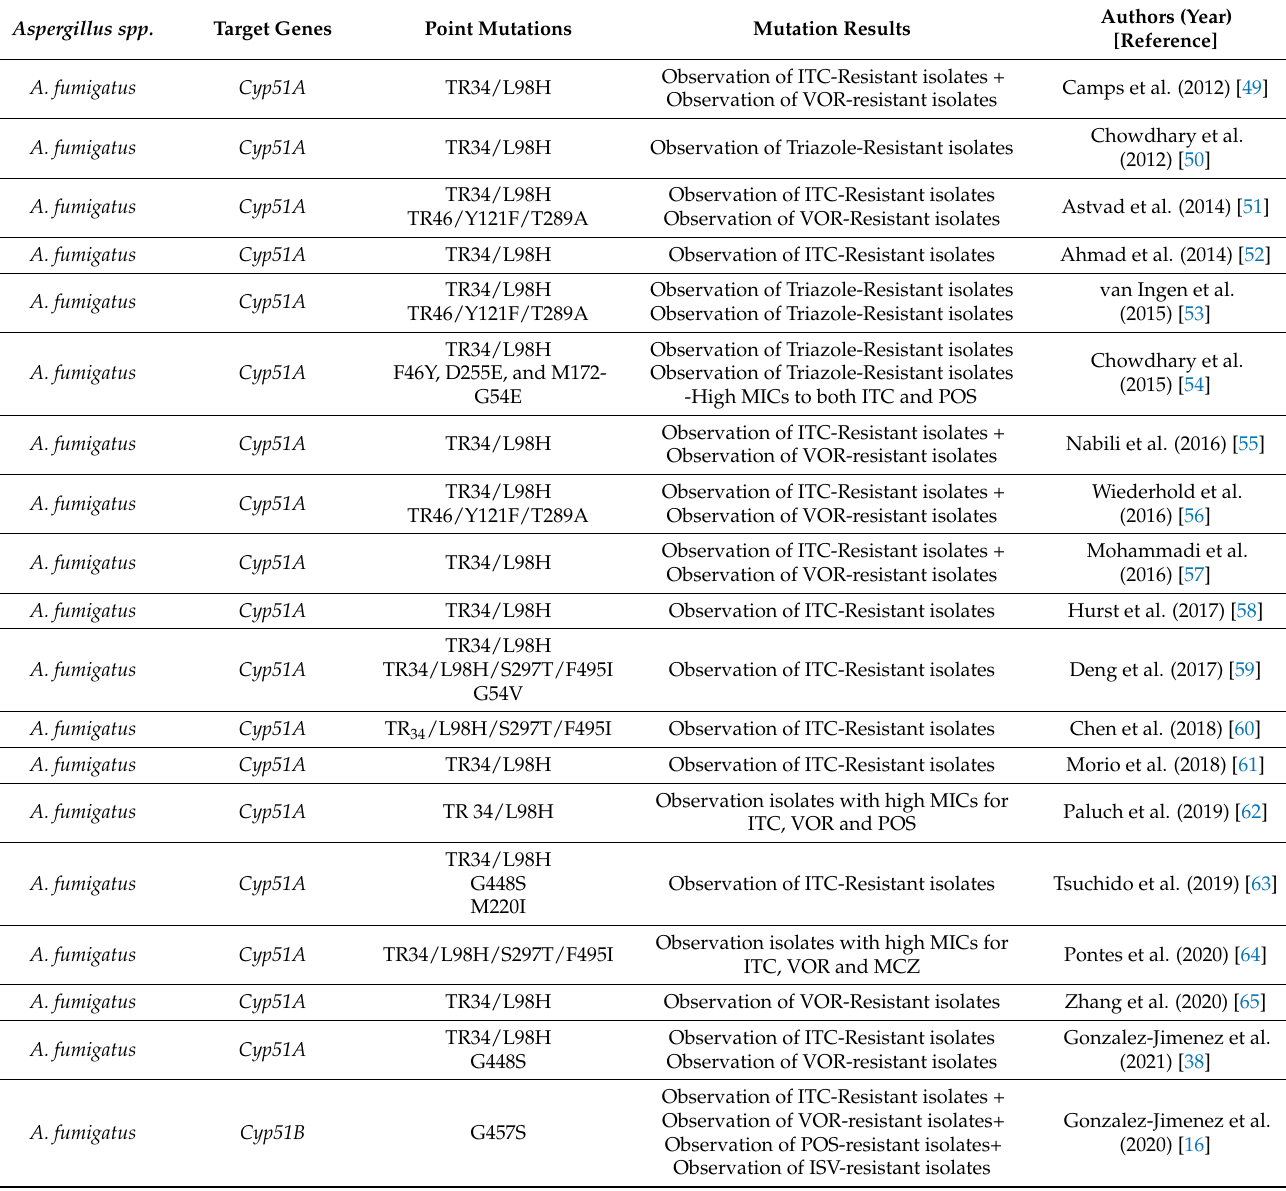
Table 3. An overview of the effects of point mutations on the emergence of azole resistance in Aspergillus spp. in the past